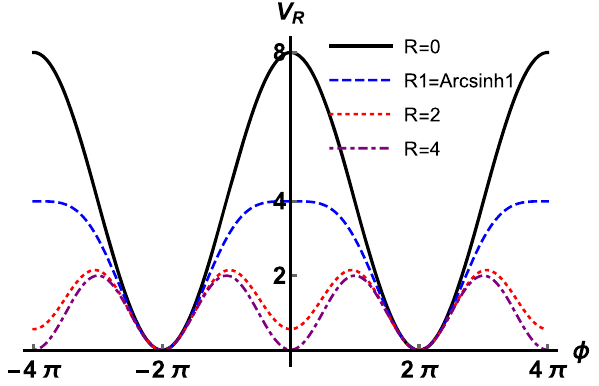
Fig. 1 The potential (19) as a function of φ for various R 1 the potential (16) is structurally similar 3. At 0 < η < 4 to the previous region, with the same set of minima. 1 4. At η > the minima of the potential (16) are φ 4